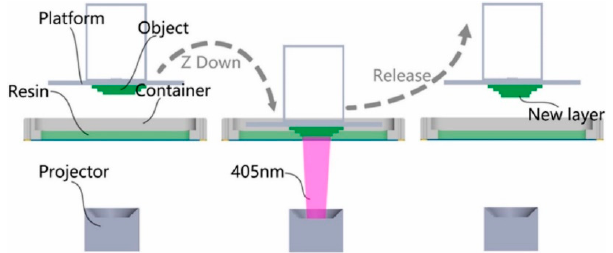
Figure 15. 3D printing process from the bottom to the top (adapted with permission from reference [46]).